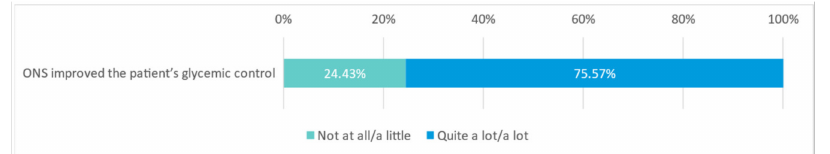
Figure 8. Improvement in the patients’ glycemic control by ONS (N = 749